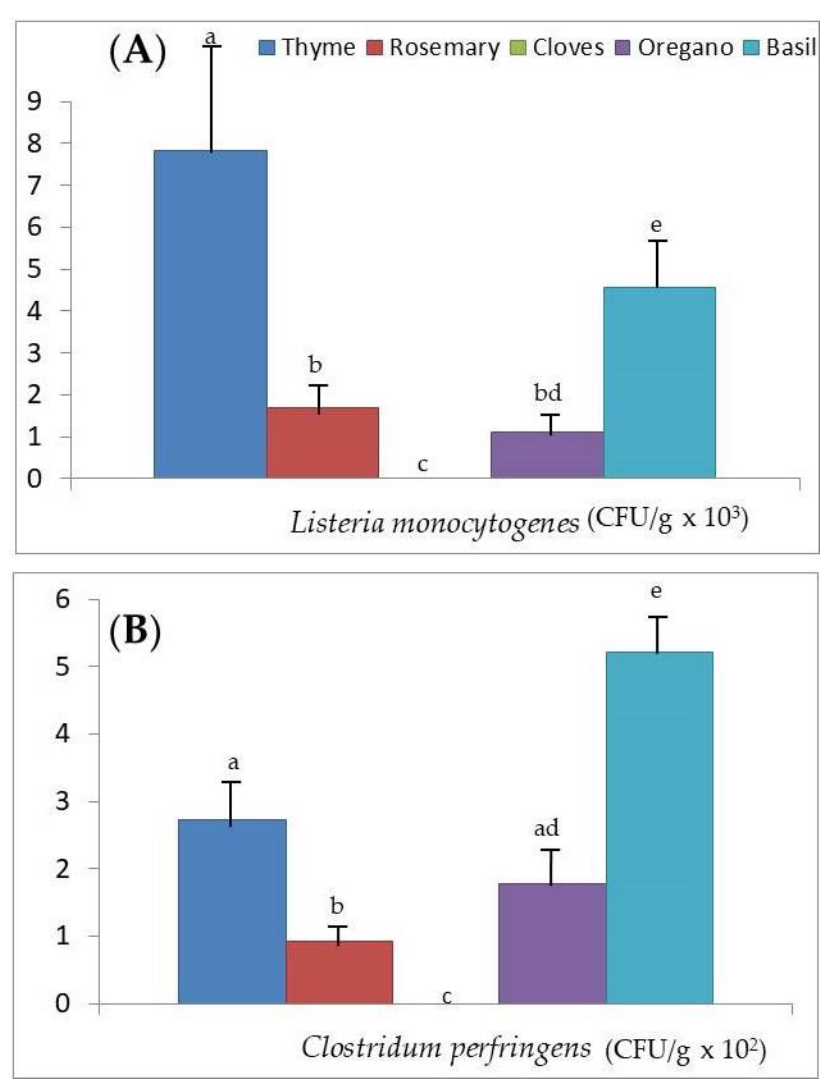
Figure 2. Microbial counts measured as colony forming units (CFU/g) for ( A ) Listeria monocytognes and ( B ) Clostridium perfringens after the addition of the dehydrated aromatic herbs (thyme, rosemary, cloves, oregano, and basil) to the culture medium. a,b,c,d,e Mean microbial counts; different superscripts indicate significant differences between the aromatic herbs ( p < 0.01).